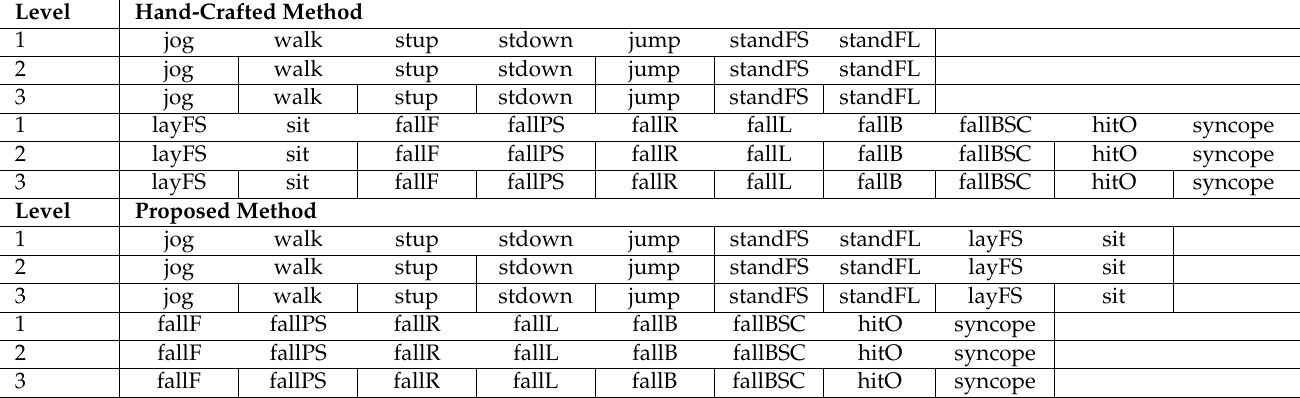
Table 6. Manually designed class hierarchy for UniMib SHAR and class hierarchy designed by the proposed